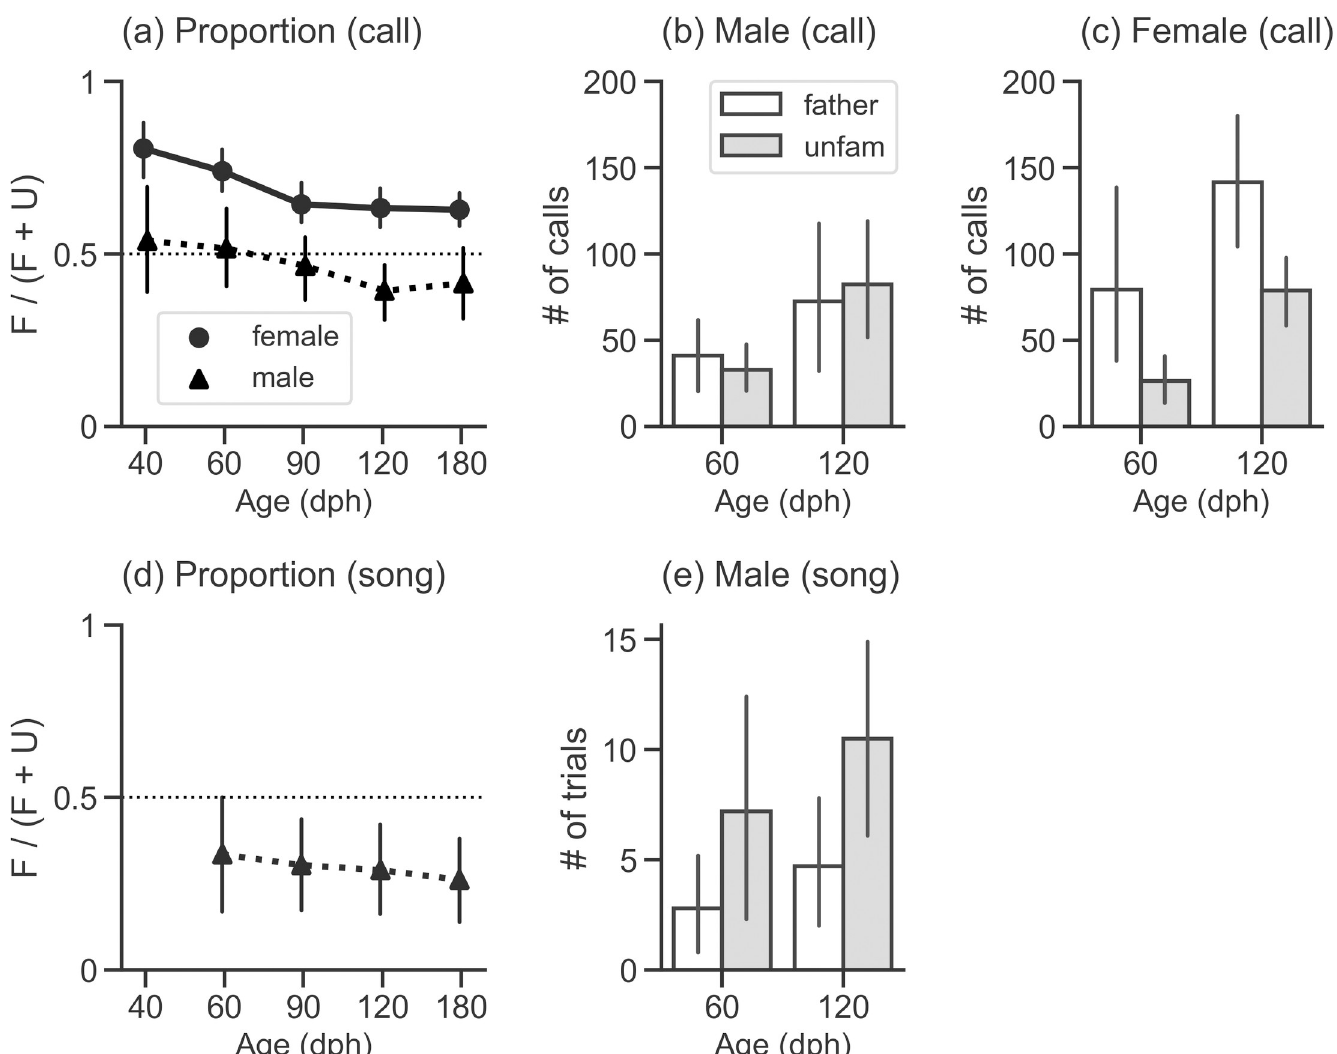
Fig 3. Results of the preference test (vocal behavior). (a, d) Population mean of the frequency proportion plotted against age of testing (the number of individuals of each sex at each age is specified in Table 3). (a) shows the results of calling, while (d) shows the results of singing (only males). A solid line with filled circles indicates female data, and a dashed line with filled triangles indicates male data. The proportion was calculated as the response frequency to the father’s song (F) divided by the total response frequency (F + U). (b, c, e) Population mean of the number of trials in which birds vocally responded to either song in the tests conducted at 60 and 120 dph. (b) shows the results of male calling, (c) female calling, and (e) male singing. We used this count data for all individuals (10 males and 10 females) for model fitting. Open bars and grey bars indicate response to the father’s song and unfamiliar song, respectively. In all three panels, error bars are 95% confidence intervals. Mean and confidence interval values are summarized in Table